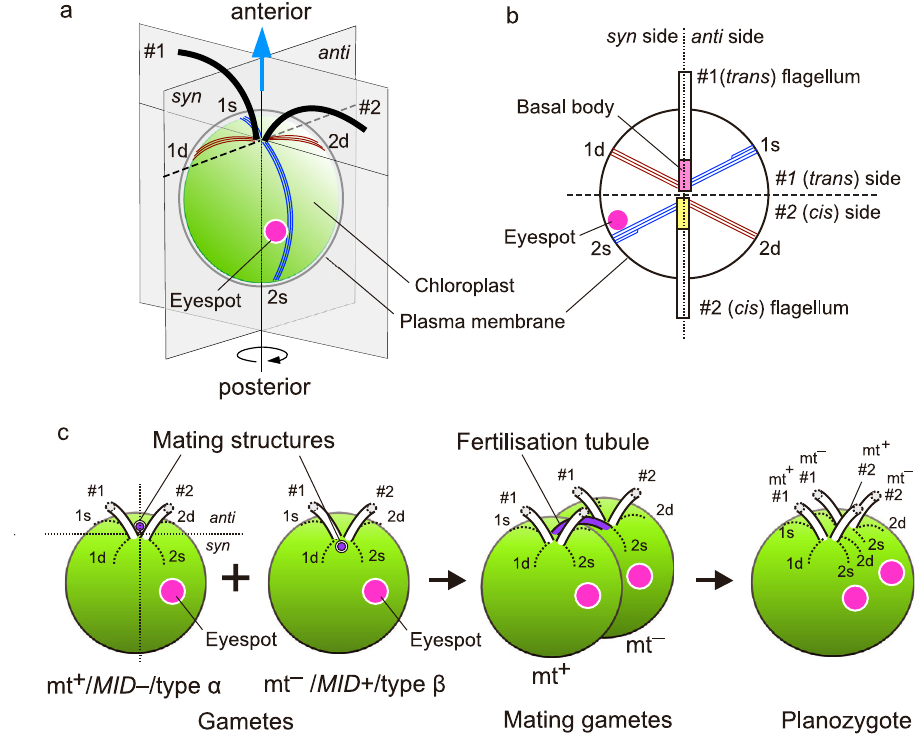
Fig. 1 Schematic diagram of the spatial arrangement of fl agellum – eyespot – mating structures in the vegetative cell, gametes, mating gametes and planozygote of Chlamydomonas reinhardtii . a Three-dimensional image of the vegetative cell. The cell wall and probasal bodies are not depicted in the diagram. The blue arrow indicates the direction and axis of cell movement. b Asymmetric organisation of the cytoskeleton and eyespot viewed from the cell anterior in the vegetative cell. c Gamete fusion and planozygote formation. The mating structure of the mt + gamete is located on the side of the beat plane opposite the eyespot (type α ), whereas that of the mt – gamete is located on the same side as the eyespot (type β ). Gamete fusion occurs between a fertilisation tubule elongated from an mt + mating structure and mt – structures. Next, the cell fusion extends between the area circumscribed by 1s – 2d microtubular roots in mt + gametes and 1d – 2s roots in mt – gametes. In the planozygote, two fl agellar pairs align in parallel, and two eyespots are positioned side by side on the same side of the cell. anti: anti side, syn: syn side, #1 : no. 1 fl agella, #2 : no. 2 fl agella, 1d, 1s, 2d, 2s : 1d, 1s, 2d, 2s microtubular roots, respectively ( a , b ), or lateral ridges overlying 1d, 1s, 2d, 2s roots, respectively ( c ), MID + : presence of MID , MID – : absence of MID